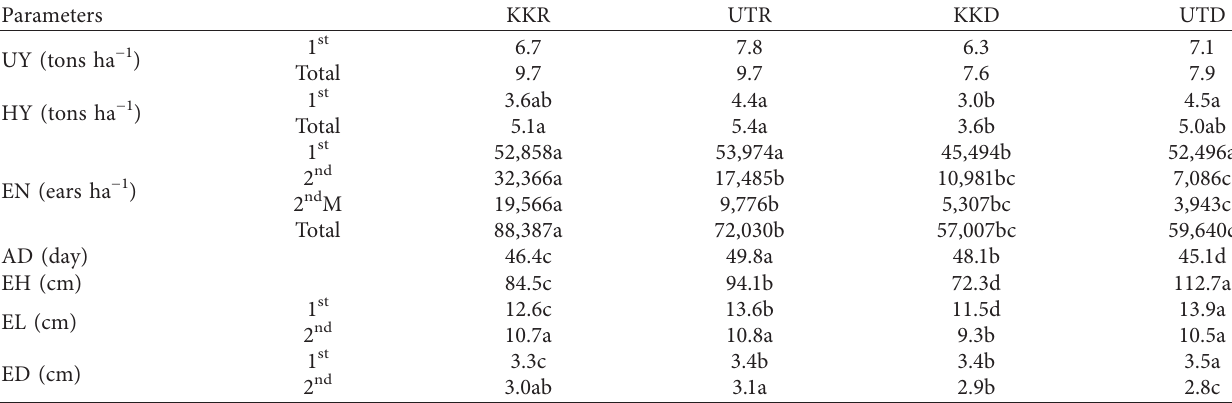
Table 3: Overall genotype means for yields, yield components, and agronomic characters of 48 small-ear waxy corn genotypes in four environments (location-season combinations) in Thailand between 2018 and